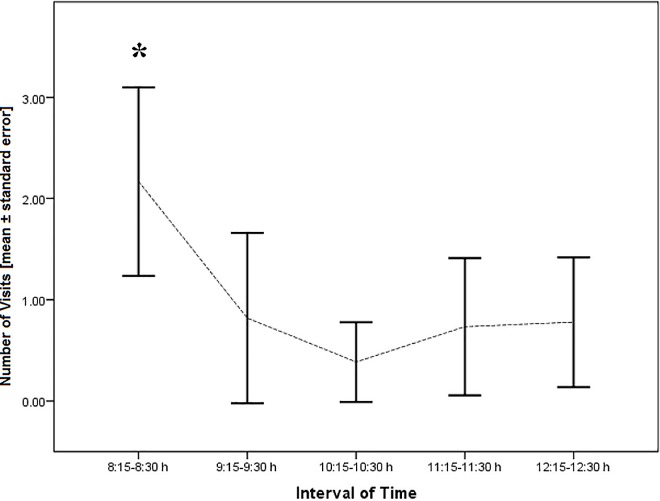
Frequency of pollinator visits to Telipogon peruvianus flowers.The number of male pollinators observed during the first interval of time (8:15–8:30 h) was significantly higher (*) than during the other intervals (Mann-Whitney-U test with Benjamini-Hochberg correction, p<0.05). Bars denote error and the dotted line the pattern of visits along the observation time.